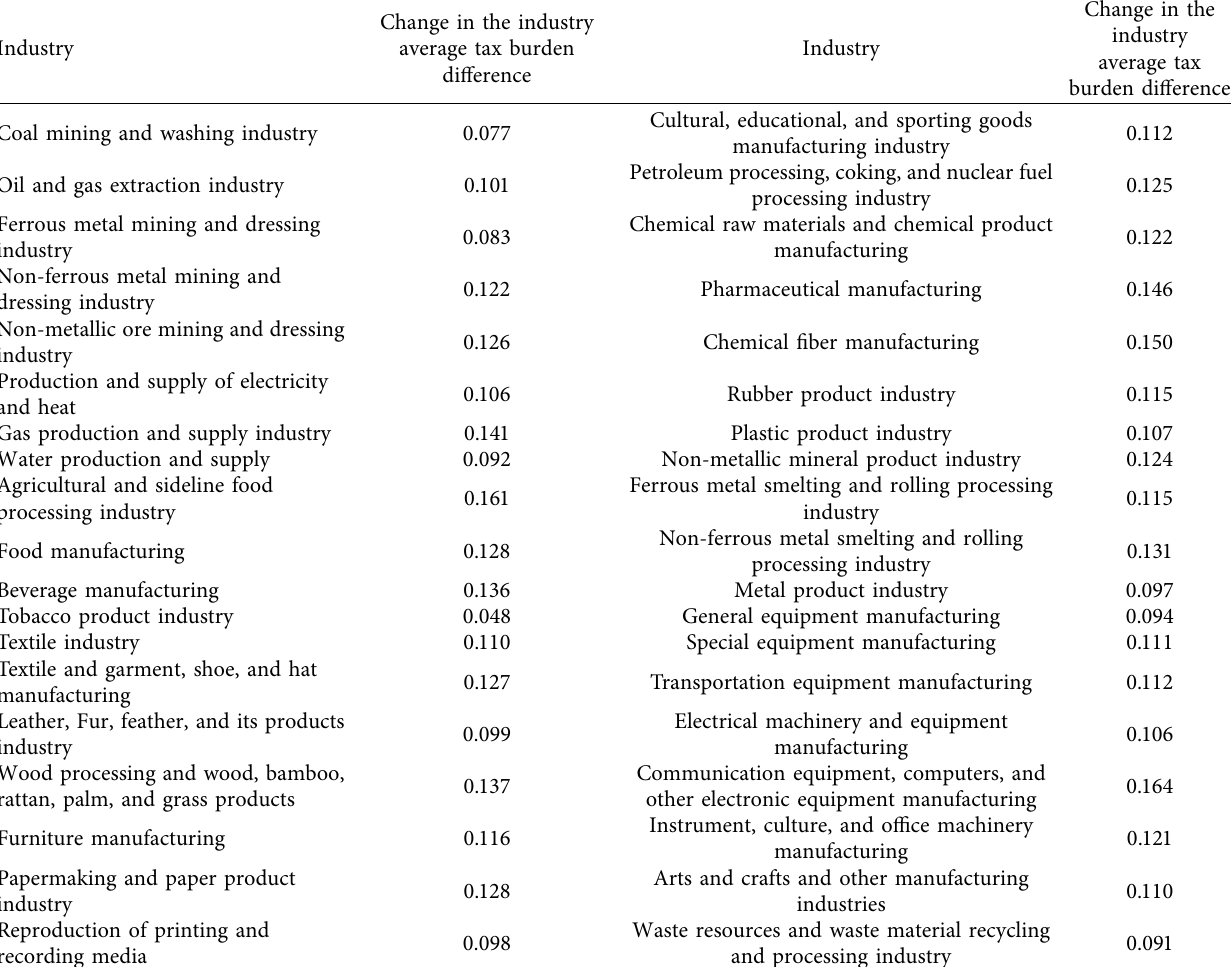
Table 3: Statistics of changes in the average tax burden of each industry in the first year of using the Internet.